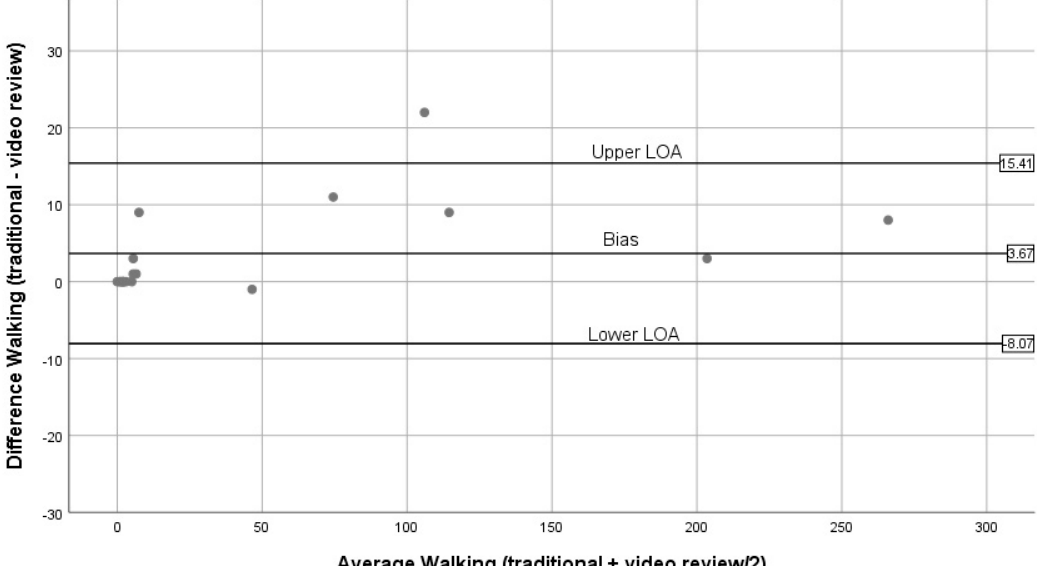
Figure 5. Bland–Altman plots for walking (traditional BWM vs. expert review of BWM videos).